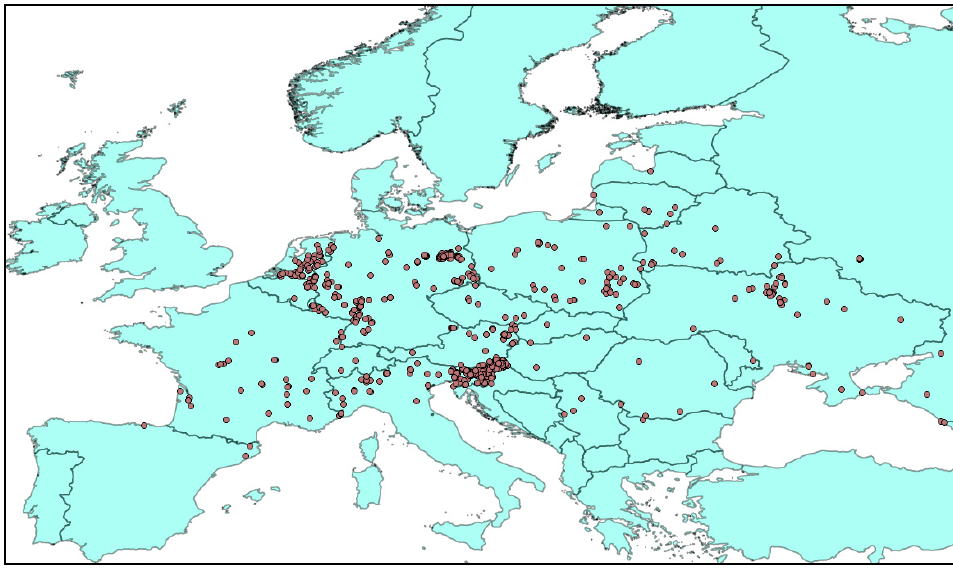
Figure 8. Map of the actual records (non-duplicable) of P. robiniella in Europe